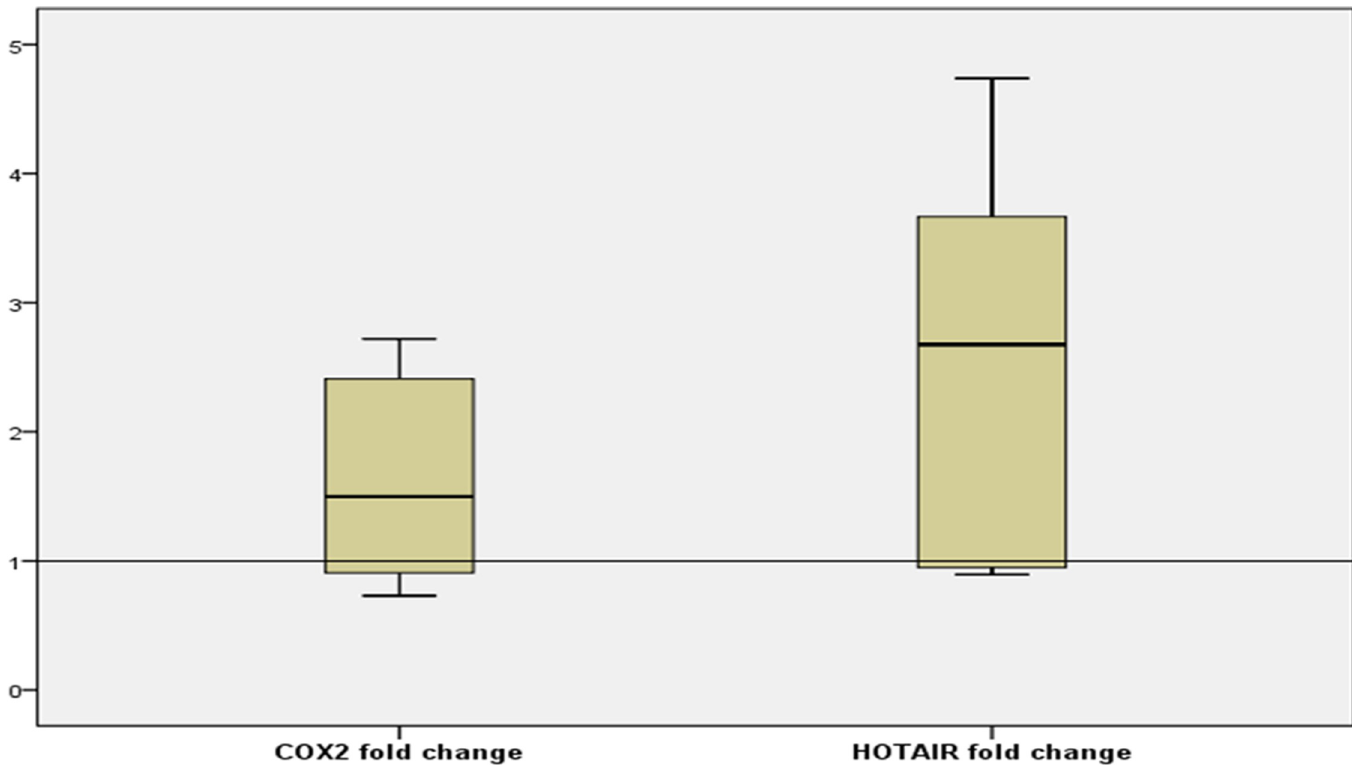
Fig 1. Comparison of expression of (a) serum lnc-Cox2 (b) serum HOTAIR (expressed as fold changes) between patients with SLE (58 patients) and healthy controls (60 subjects). The expression levels were analyzed by real-time quantitative PCR and normalized by GAPDH level. (a) Significantly increased expression of lnc-Cox2 in patients with SLE versus healthy controls (b) Significantly increased expression of HOTAIR in patients with SLE versus healthy controls.